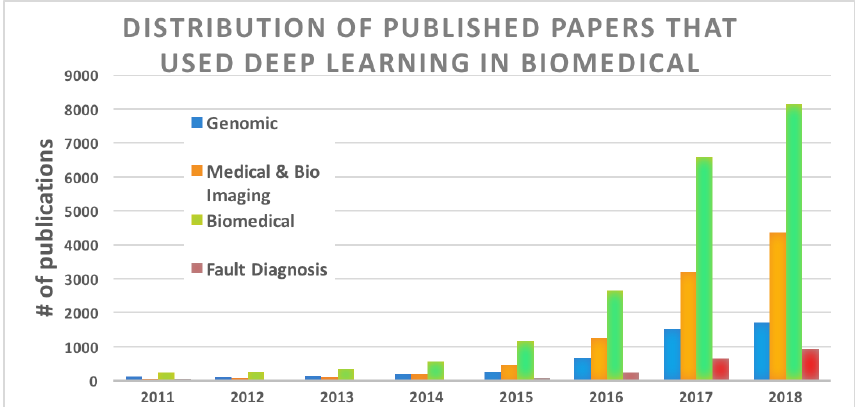
Figure 1. Distribution of published papers involving deep learning in biomedical applications. The statistics are obtained from Google Scholar; the search phrase is defined as the subfield name with deep learning, e.g., “genomics” and “deep